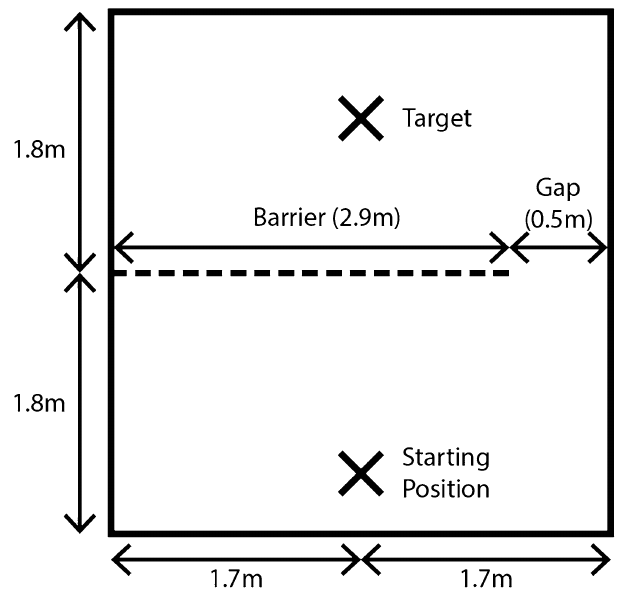
Figure 2. Set up of experimental room. The subject was placed on the starting position opposite the experimenter. In the learning trials, the experimenter would get the dog’s attention, show it the treat, place the treat in a bowl, and place the bowl on the target. After the experimenter gave the release command, the owner would release the dog and the dog would have to enter through the gap in the barrier to reach the treat. The test trials were the same as the learning trials, but the gap was moved to the other side. The experimental procedure was the same except that in the scaffolding conditions, the experimenter would either point to the gap or demonstrate the route before giving the release